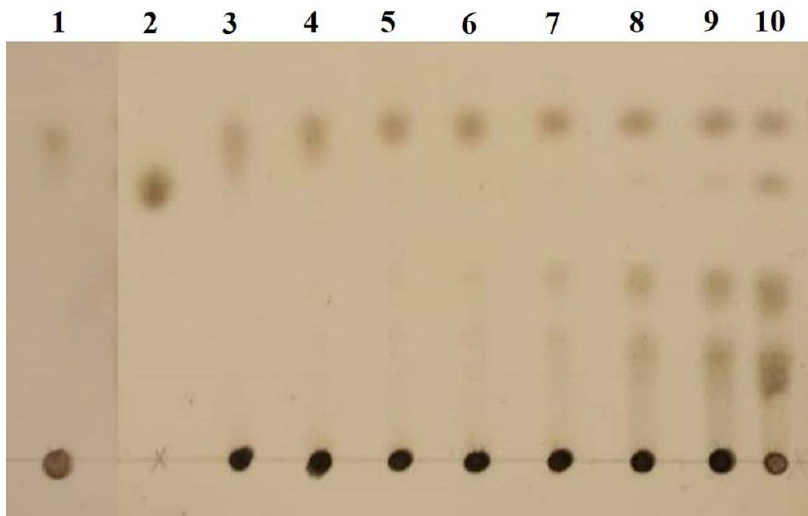
Figure 7. TLC (thin-layer chromatography) analysis of the hydrolysis of PGA by AnEPG. Hydrolysis of PGA was completed in 50 mM B & R (Britton and Robinson) bu ff er (pH 4.0) at 37 ◦ C for 5 min, 10 min, 20 min, 30 min, 1 h, 2 h, 3 h, and 24 h, respectively. The hydrolysis products were analyzed by TLC on the silica gel plate. Lane 1: the control in the absence of enzyme AnEPG; Lane 2: galacturonate; Lanes 3–10: enzymatic hydrolysis products of PGA by AnEPG after being incubated for 5 min, 10 min, 20 min, 30 min, 1 h, 2 h, 3 h, and 24 h, respectively.